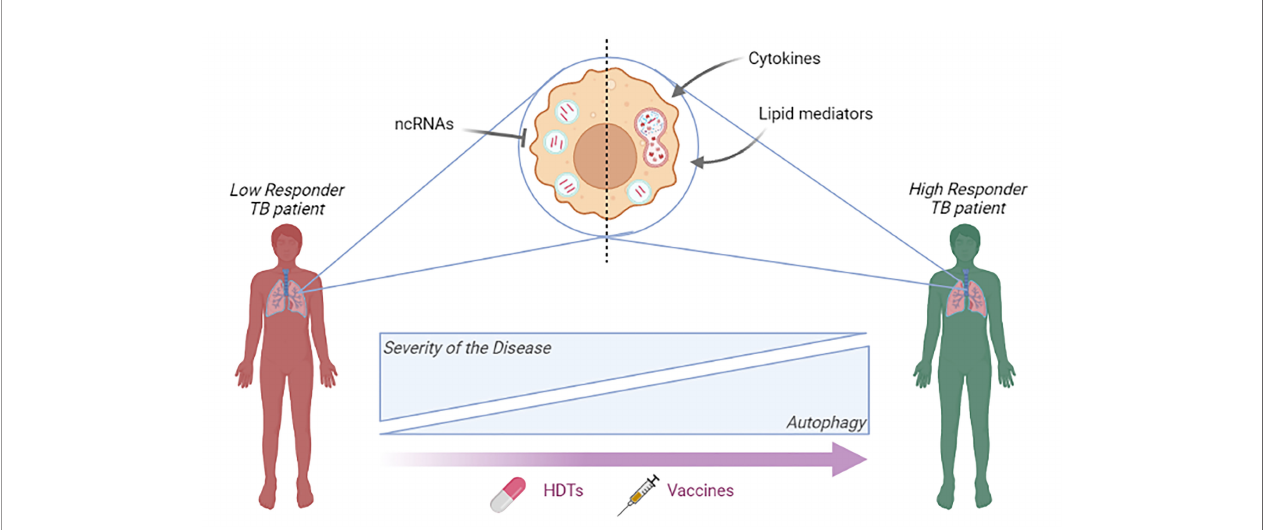
FIGURE 1 | A simpli fi ed model of the role of autophagy in TB patients according to their immunological response to Mtb . The potential in fl uence of immunological mediators and ncRNAs on autophagy is shown. High responder TB patients correspond to patients that display strong T cell immunity to Mtb , which correlates with milder manifestations of the disease (Pasquinelli et al., 2004; Jurado et al., 2012) and robust autophagic responses, as previously demonstrated (Rovetta et al., 2014; Tateosian et al., 2017). In contrast, patients with weak or no T cell responses to Mtb are associated with more severe disease (Pasquinelli et al., 2004; Jurado et al., 2012) and diminished autophagy (Rovetta et al., 2014; Tateosian et al., 2017). The purple arrow indicates the hypothetical impact of new HDT strategies (e.g.: autophagy as adjuvant therapy) in the treatment of TB patients and novel vaccines inducing an autophagic response. Figure created with